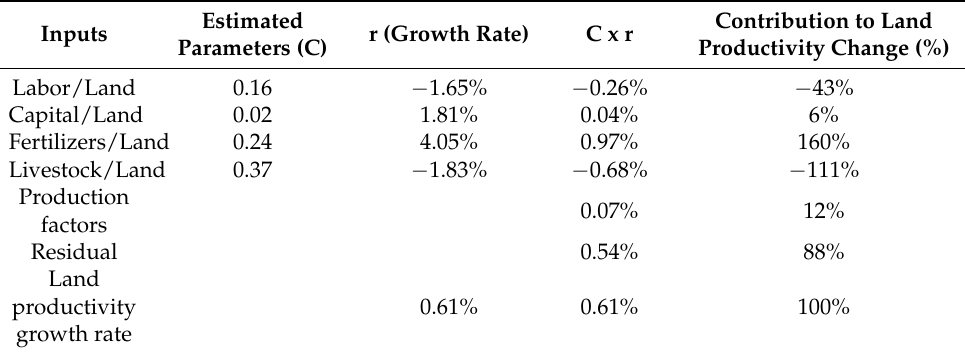
Table 2. Estimation of contribution of production factors to land productivity change.